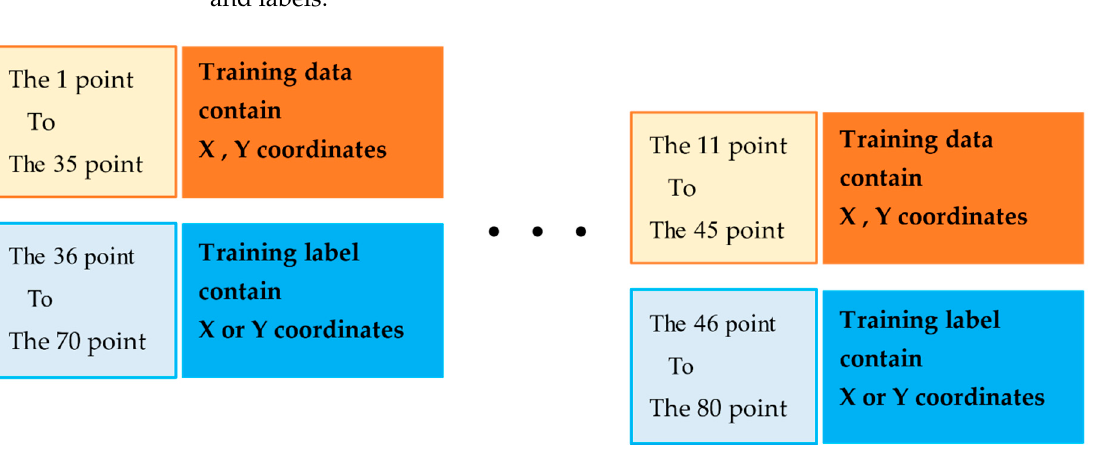
Figure 18. The process of our training data and training labels.